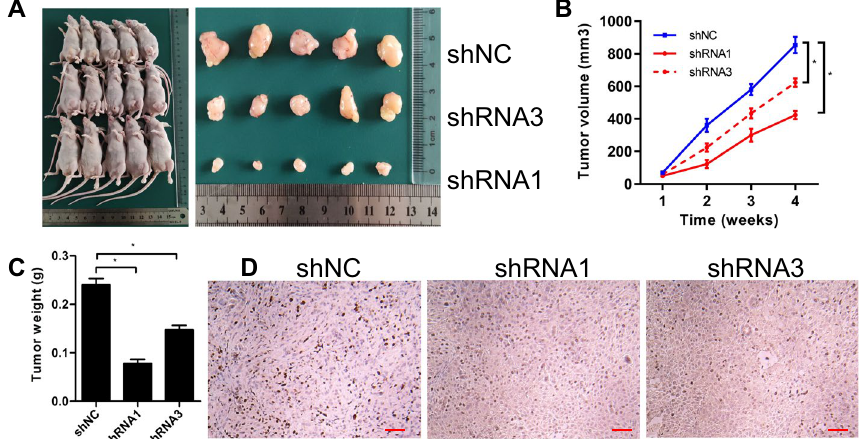
Fig. 6 GALNT2 knockdown suppresses tumor growth in vivo. A Representative images of xenograft tumors formed. B Tumor growth curves. C Tumor weights. D Ki67 staining of tumor tissues (bar GALNT2 shRNA lentivirus, shNC negative control shRNA lentivirus. * P <